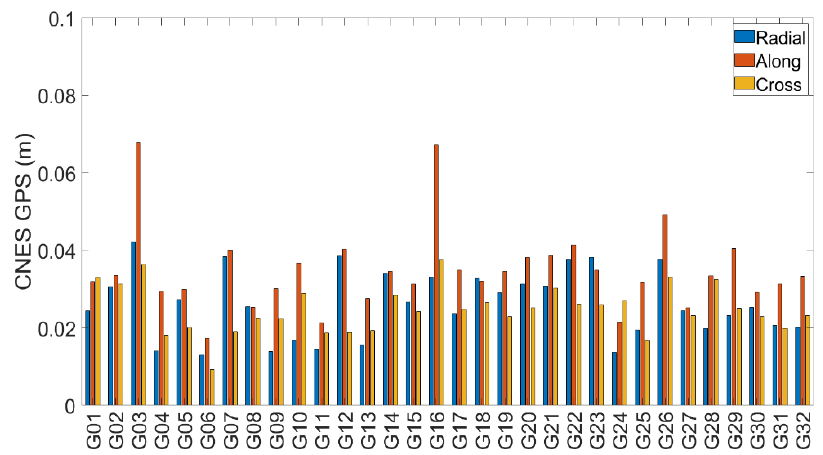
Figure 2. RMS values of GPS orbit errors for the CNES products.